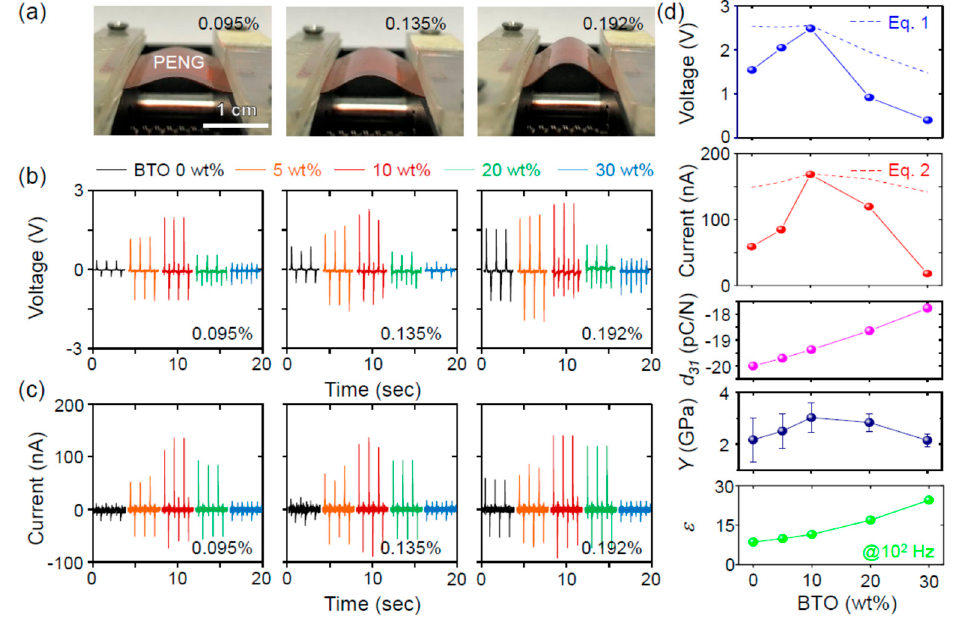
Figure 4. ( a ) Photographs of a bent PVDF–BTO composite piezoelectric nanogenerator (PENG) at selected strain values. The ( b ) open-circuit voltage and ( c ) closed-circuit current as a function of BTO content at selected strain values and at a fixed bending speed of 37 mm/s. ( d ) Comparison of the piezoelectric outputs with the predicted piezoelectric coefficient, measured Young’s modulus, and dielectric constant. The dashed lines in ( d ) represent the calculated piezoelectric outputs based on Equations (1) and (2).